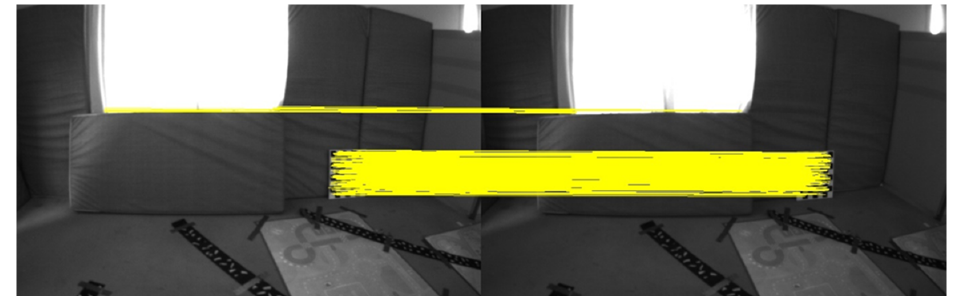
Figure 7. Results of feature point extraction and matching.